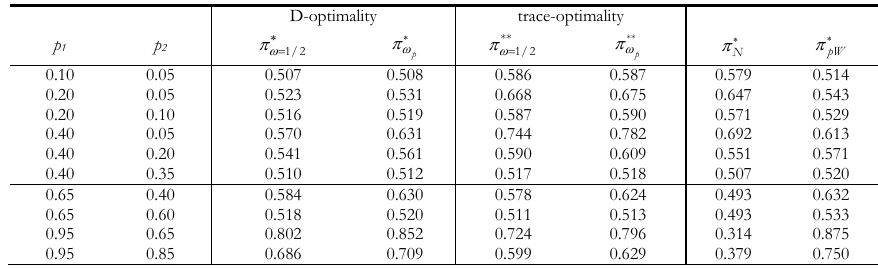
Values of the compound targets for D- and trace-optimality, corresponding to ω =1/2 and ω p =(|p 1 -p 2 |+ 1 )/ 2 , for different choices of p 1 and p 2 D-optimality